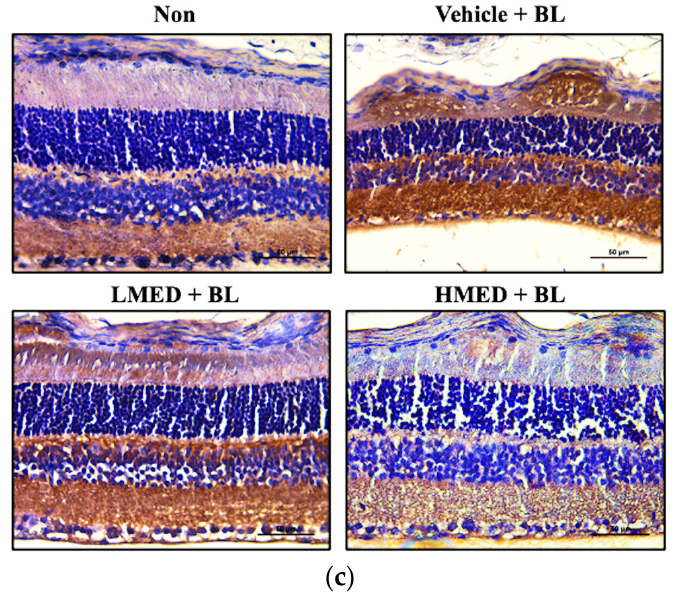
Figure 12. Tissue distribution of ( a ) Nrf2, ( b ) COX-2 and ( c ) iNOS protein in the retina of MED + BL treated Balb/c mice. After staining specific antibodies, the stained section of retina was observed at 200× magnification using light microscopy. Brown or dark brown indicates the expression of three proteins, and dark blue indicates the nucleus. The immunostained slides were prepared from three to five mice per group, the color density analyses for each sample were performed in duplicate.